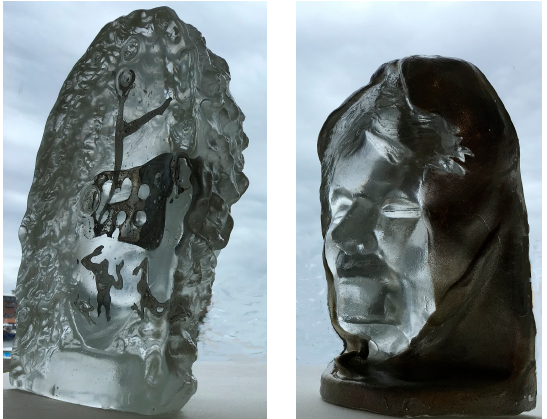
Figure 4. Goshka Bialek; Self-portrait I & II , 2017; inclusion of nickel, lead, and tin alloy in Cristalica glass; hot pouring into the mold; created by author.